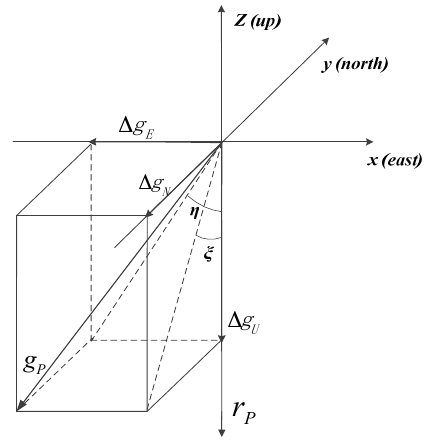
Figure 2. The deflection of the vertical.